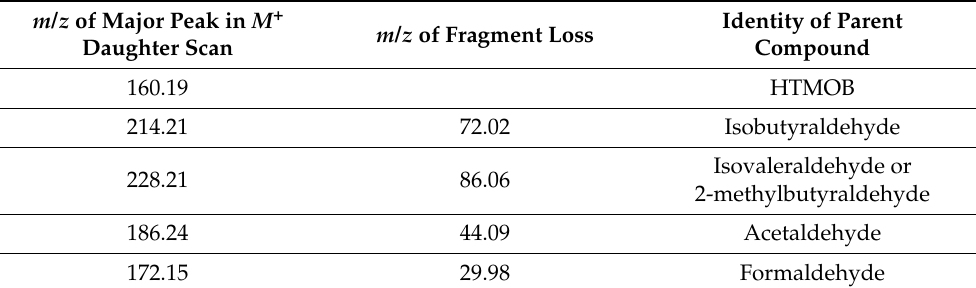
Figure 4. Mass spectrum of the HTMOB-derivatized carbonyl extract obtained from browned meat juices by condensation with silica-gel supported reagent. ESI-MS full scan mode (below) and ESI-MS/MS neutral loss 59 Da mode (above). Table 2. Analysis of ESI-MS/MS neutral loss of 59 Da spectrum of the HTMOB- derivatized carbonyl extract obtained from analysis browned meat juices sample.